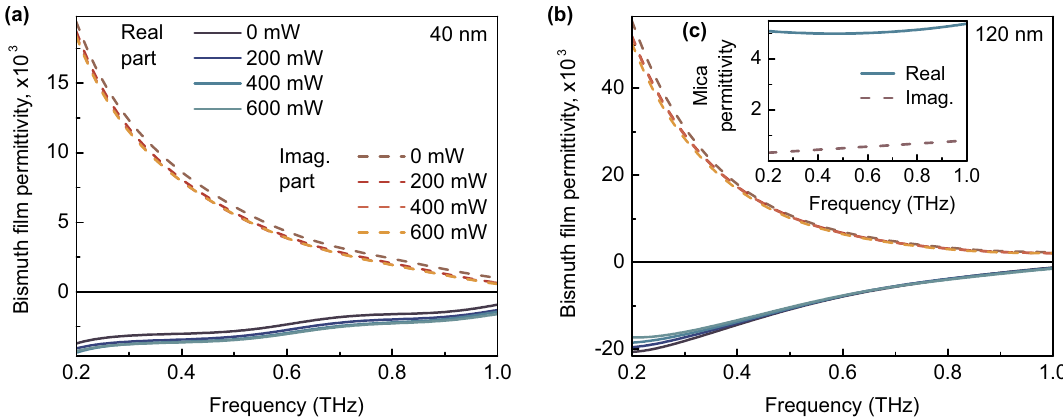
Figure 4. Results of experiment (material parameters). Complex permittivity dispersion of 40 ( a ) and 120 ( b ) nm bismuth films for various power of optical pumping. Inset: complex permittivity dispersion of mica substrate ( c